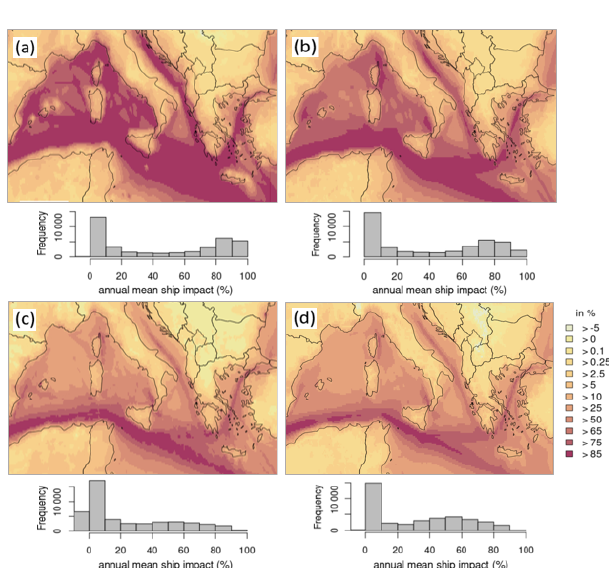
Figure 12. Annual total dry deposition of NO 2 . (a) CAMx; (b) CHIMERE; (c) CMAQ; (d) LOTOS-EUROS. Below the do- main figure the respective frequency distribution is displayed for the annual mean NO 2 dry deposition, referring to the whole model domain.